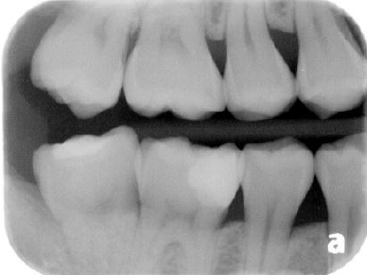
Figure 7. After finishing and polishing: ( a ) occlusal view; and ( b ) mesial view.